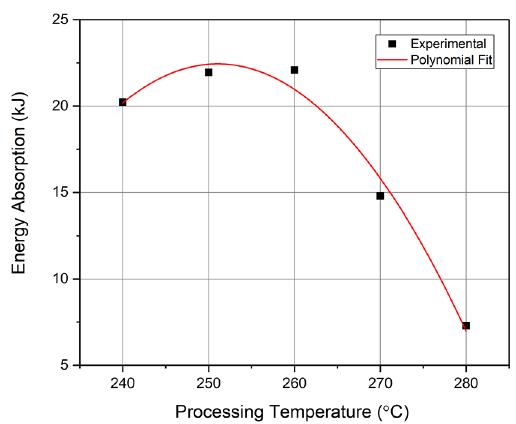
Figure 10. Energy absorption determinated by CAI test. (Bibliographic Source: